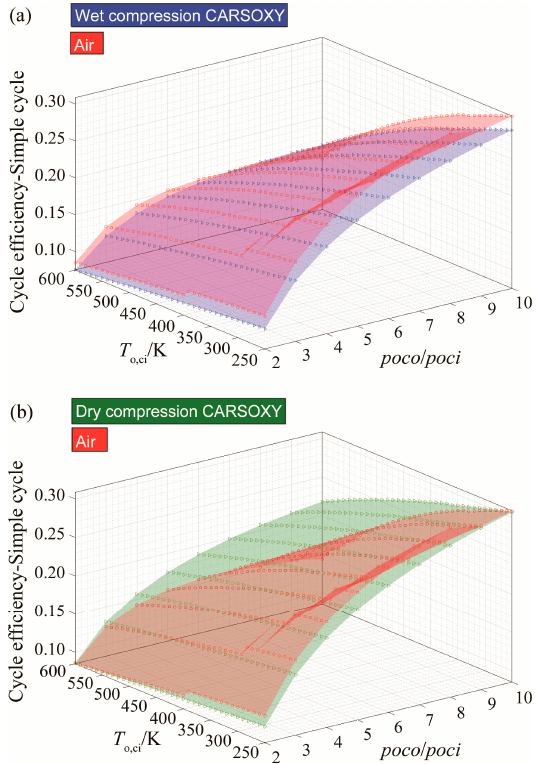
Figure 2. Efficiency results for the simple cycle using ( a ) wet compression and ( b ) dry compression. Figure 2. E ffi ciency results for the simple cycle using ( a ) wet compression and ( b ) dry